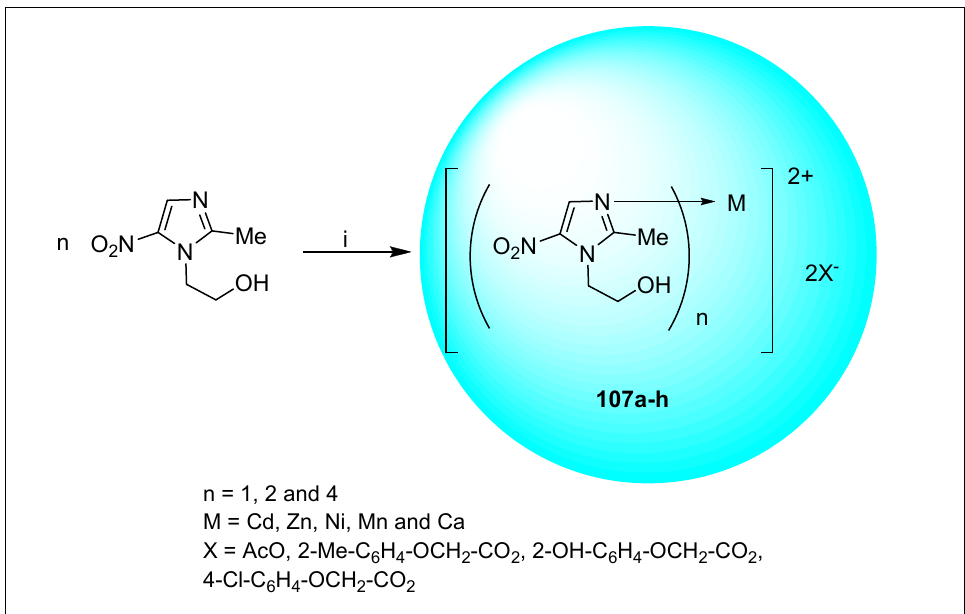
Adamovich et al., in the year 2014, performed the reaction of